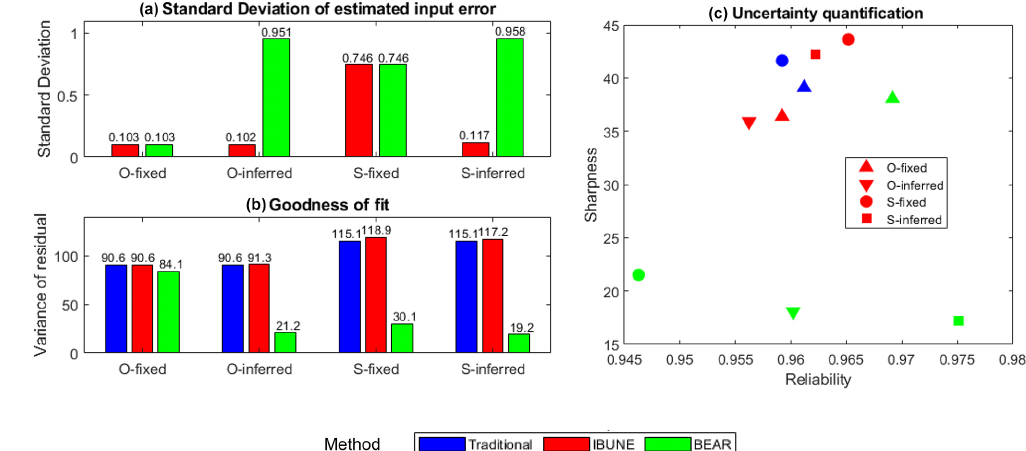
Figure 4. Comparison of the statistical characteristics of four calibration scenarios in the real case (including O -fixed, O -inferred, S -fixed, and S -inferred; their notations are given in Table 2) via three calibration methods (including the traditional method, the IBUNE method, and the BEAR method; their algorithms are explained in Sect.